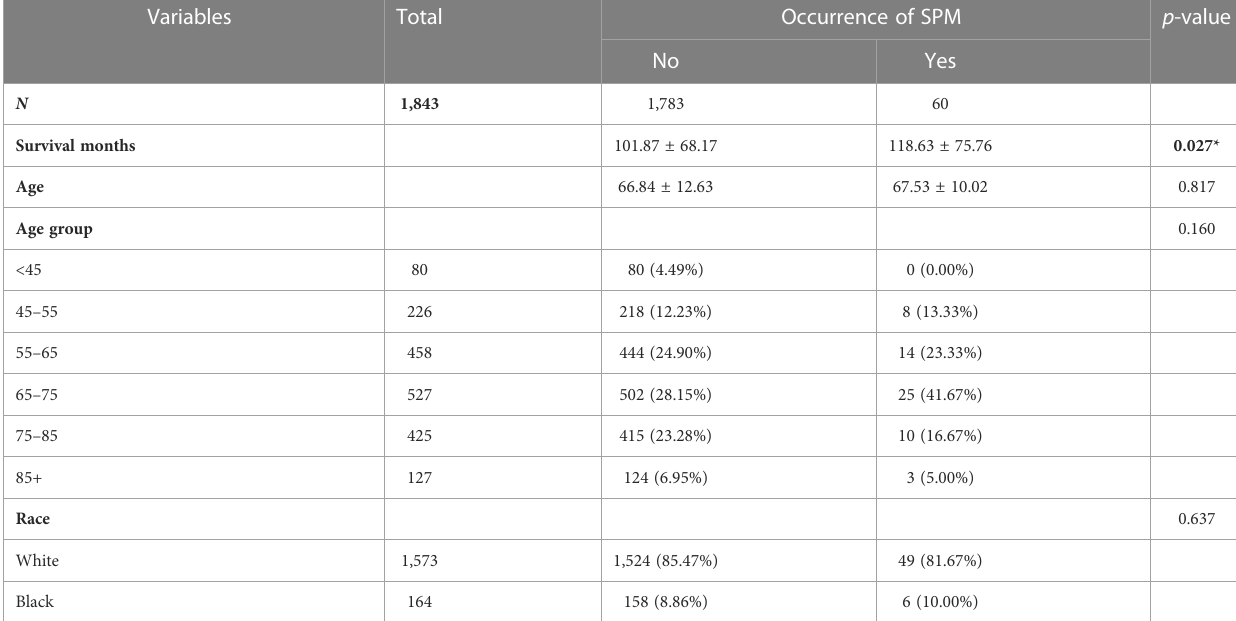
TABLE 2 Patient characteristics (with or without